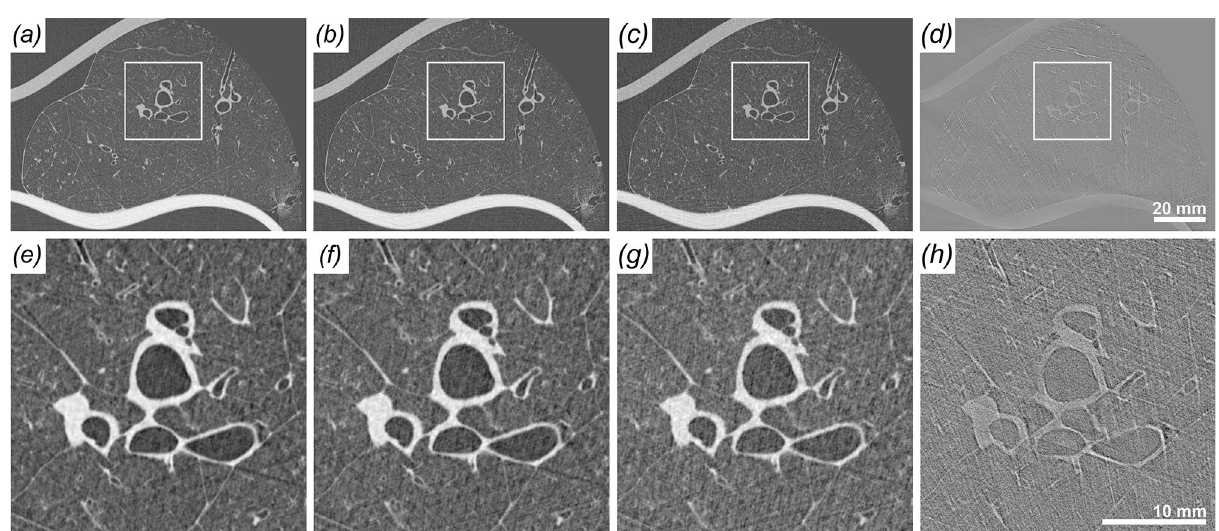
Figure 2. Comparison of the image quality of a healthy pig lung at different dose levels. To simulate lower entrance doses reconstructions with less angular projections are shown. ( a ) Full 8100 projections, entrance dose 10 mGy. ( b ) Half 4050 projections, entrance dose 5 mGy. ( c ) Quarter 2025 projections, entrance dose 2.5 mGy. ( d ) Full 8100 projections, entrance dose 10 mGy, no phase retrieval applied. ( e ), ( f ), ( g ), ( h ) show zoomed in parts of the images above. No visible difference are found between full and half dose while for a quarter of the dose the image quality diminishes a bit. Without phase retrieval the lung structure can barely be